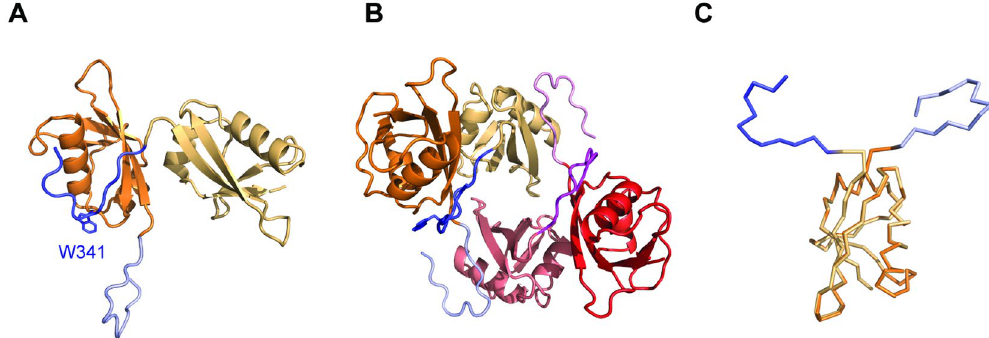
Figure 2. Structure of UIS-UFM1 complex. ( A ) Crystal structure of the UFM1 interacting sequence (UIS) of UBA5 fused to UFM1 (orange). The asymmetric unit contains two molecules A & B. Each molecule possesses a UFM1 part (orange) and a UIS part (blue). ( B ) Two asymmetric units possessing four molecules of UIS- UFM1 form a round structure where each molecule interacts with one molecule via the UFM1 part and another molecule via the UIS part. The two molecules that are colored as in A arrive from one asymmetric unit and the other two molecules come from adjacent asymmetric unit. ( C ) Superposition of the two UIS-UBA5 molecules in the asymmetric unit. Superposition was performed with the UFM1 part of each molecule. Colors are as in